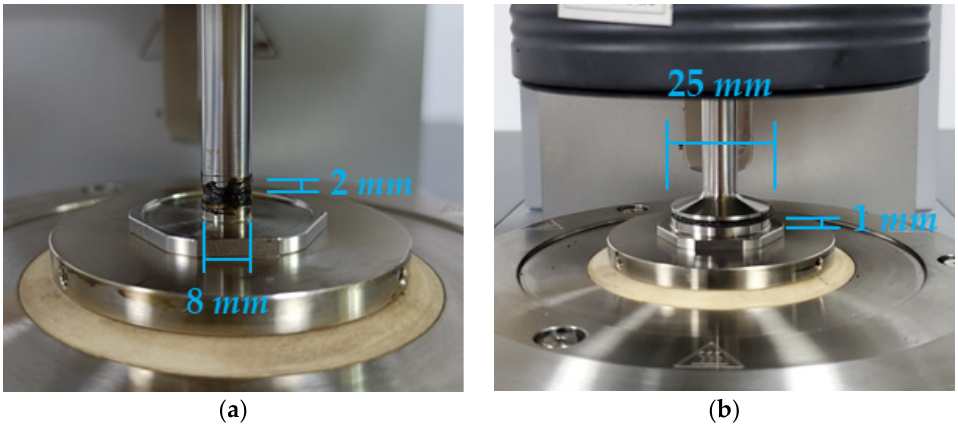
Figure 1. Parallel plate size and sealant sample size in DSR at different temperatures. ( a ) 30 °C and 40 °C; ( b ) 50 °C, 60 °C and 70 °C .